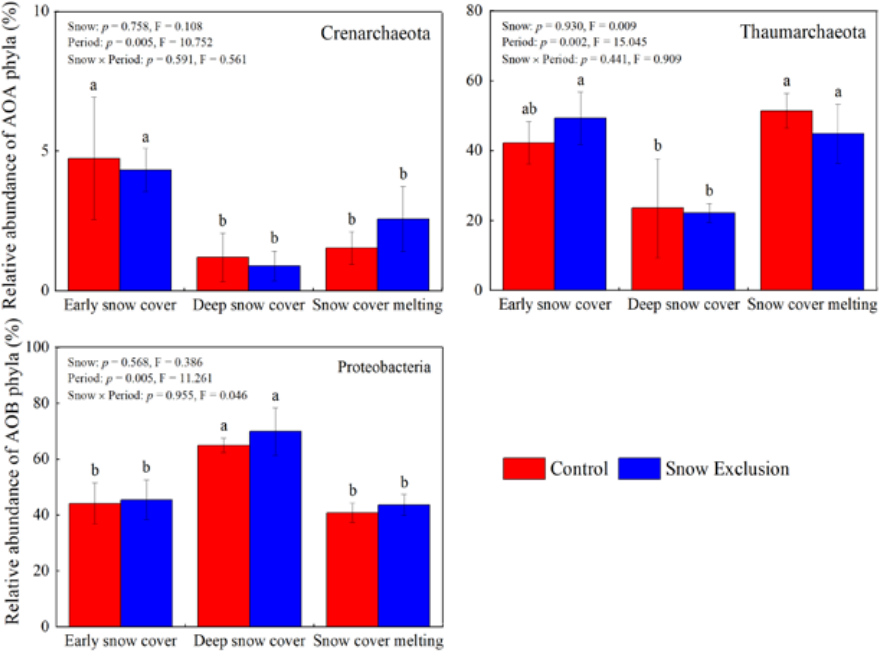
Figure 5. Relative abundance of the known group of AOA and AOB communities at the phylum level in winter. Different lowercase letters indicate significant differences between sampling periods under the same snow regime. The p -values for snow treatment (Snow), sampling period (Period), and their interactions from repeated measures ANOVA are inserted in the figure.